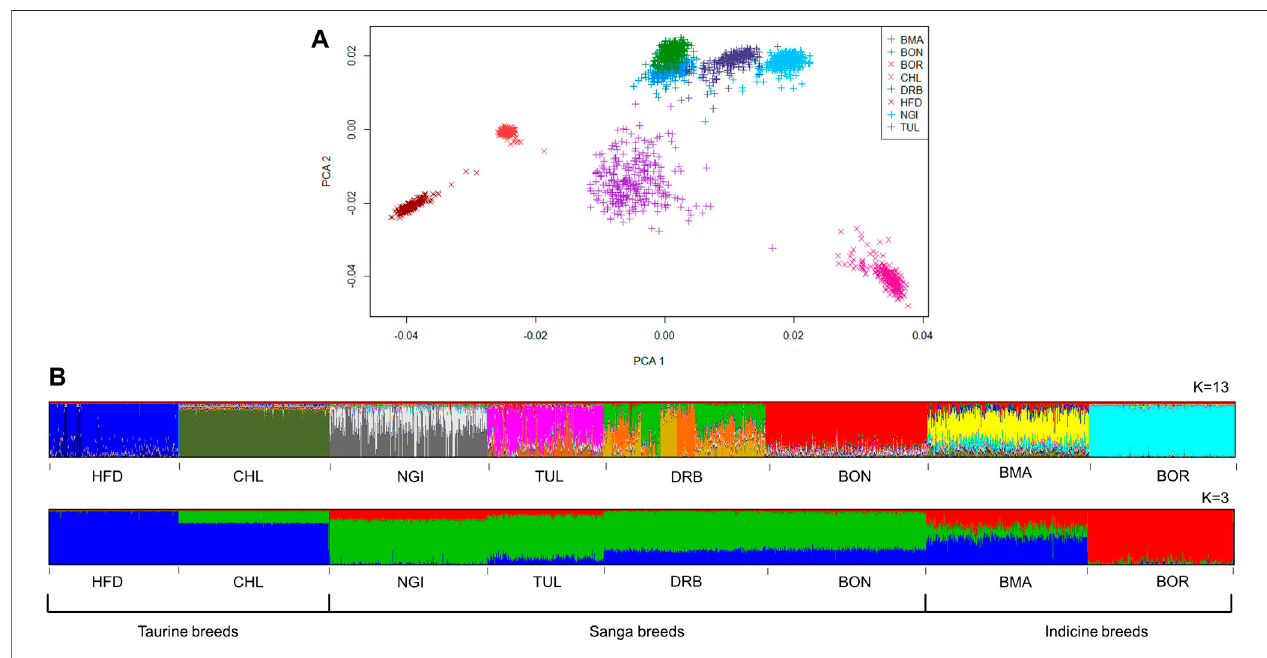
FIGURE 3 | Genetic structure of South African cattle breeds, according to model-based clustering (A) and principle component analysis (B) .